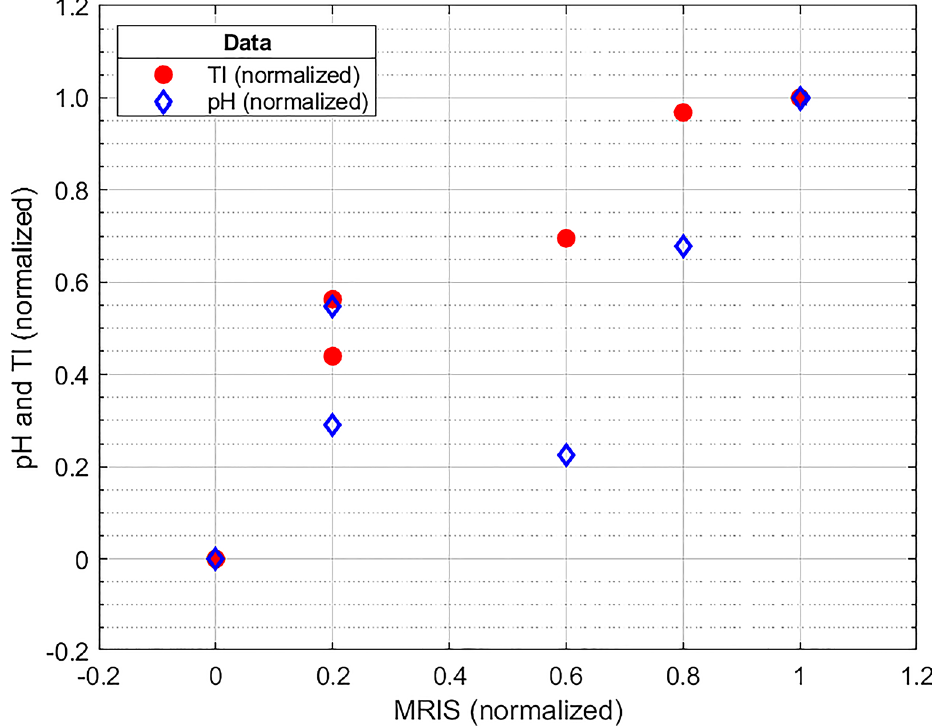
Figure 1. Correlation between the MRIS and the pH and TI scales (all variables were min–max normalized to [0;